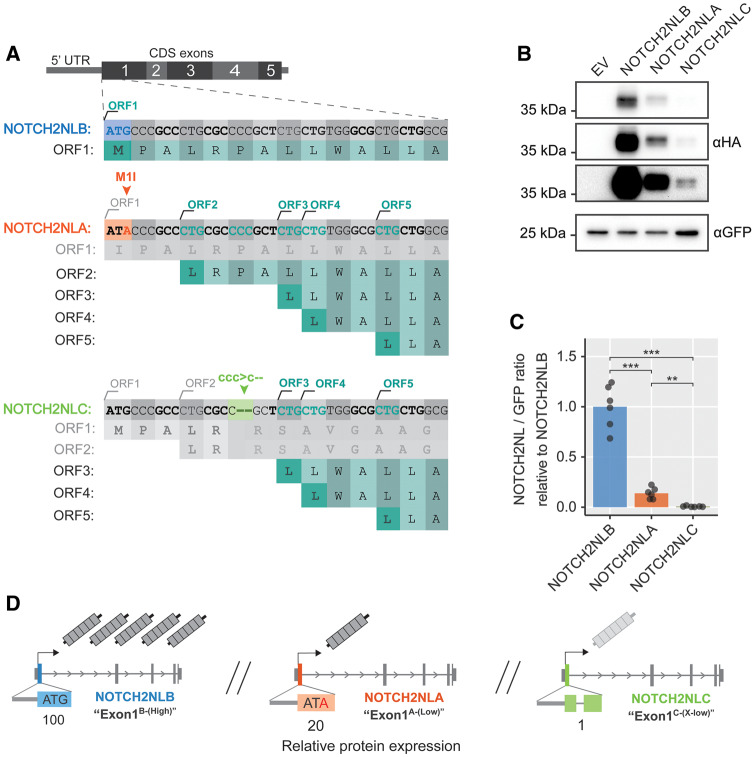

NOTCH2NL Exon1 variants define protein expression level. (A) Overview of NOTCH2NL Exon1 variants in NOTCH2NLB (blue), NOTCH2NLA (orange), and NOTCH2NLC (green). The ORFs produced by each variant are indicated in dark green. (B) Western blot analysis of NOTCH2NL Exon1 coding variants. (C) Quantification of protein expression level from equimolar quantities of NOTCH2NLB, NOTCH2NLA, or NOTCH2NLC full-length cDNAs. Data from six independent experiments, analysis of variance (ANOVA) (Welch corrected) P = 2.7e-05, followed Games–Howell test: **P < 0.01 and ***P < 0.001. (D) Overview of NOTCH2NL loci, the configuration of the Exon1 variants, and the relative levels of NOTCH2NL protein they produce.